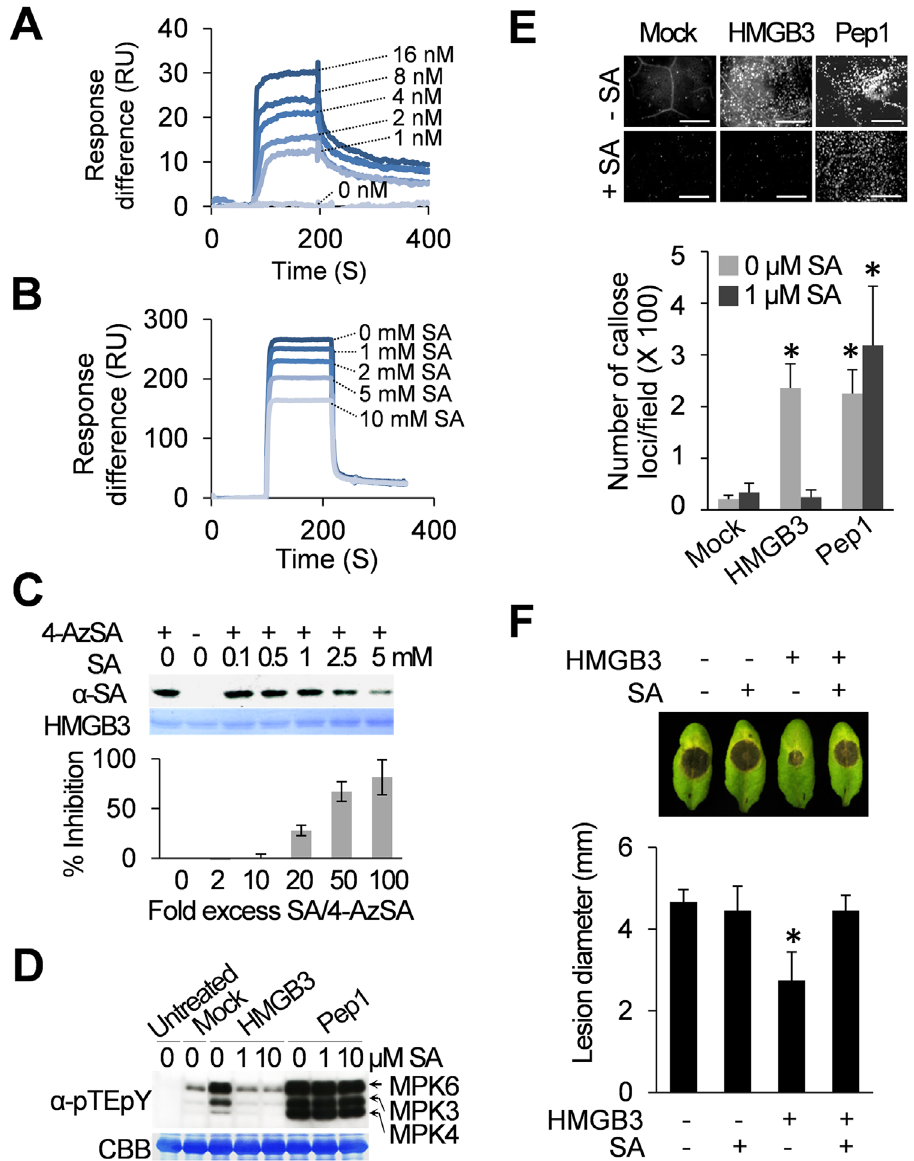
Fig 5. SA binds to HMGB3 and inhibits its DAMP activity. A - B. SPR analysis of HMGB3 ’ s SA-binding activity. A. Sensorgrams obtained with different concentrations of HMGB3 using a 3AESA-immobilized sensor chip. B. Sensorgrams obtained with 1 μ M HMGB3 in the presence of indicated concentrations of SA using a 3AESA-immobilized chip. The signals detected from a mock-coupled control chip were subtracted. C. Photoaffinity labeling of HMGB3 using 4-AzSA. HMGB3 was incubated with 50 μ M 4-AzSA in the presence of different concentrations of SA, and then exposed to UV light (30 mJ). HMGB3 labeled with 4-AzSA was detected by IB analysis with α -SA antibodies. HMGB3 stained with CBB served as a loading control. The results are expressed as a percentage of inhibition in the presence of the indicated fold excess of SA as compared to the amount 4-AzSA crosslinked HMGB3 formed in the absence of SA, which was assigned 0% inhibition. Data are the mean ± SD (n = 2). D. SA inhibited HMGB3-induced, but not Pep1-induced, MAPK activation. Leaves were collected 15 min after infiltration with water (mock) or with water containing either 1 μ M HMGB3 or Pep1 in the presence of the indicated concentrations of SA. Leaves not infiltrated served as an untreated control. Phosphorylated, and thus activated, of MPK3, MPK4, and MPK6 were detected with α - pTEpY antibody. Rubisco large subunit protein stained with CBB served as a loading control. E. SA inhibited HMGB3 ’ s, but not Pep1 ’ s, ability to induce callose deposition. Leaves were stained with aniline blue 15 h after infiltration with water containing 0.1 μ M HMGB3 or Pep1 in the presence or absence of 1 μ M SA. Representative pictures are shown in upper panel. Bars = 100 μ m. Data are the mean ± SD (lower